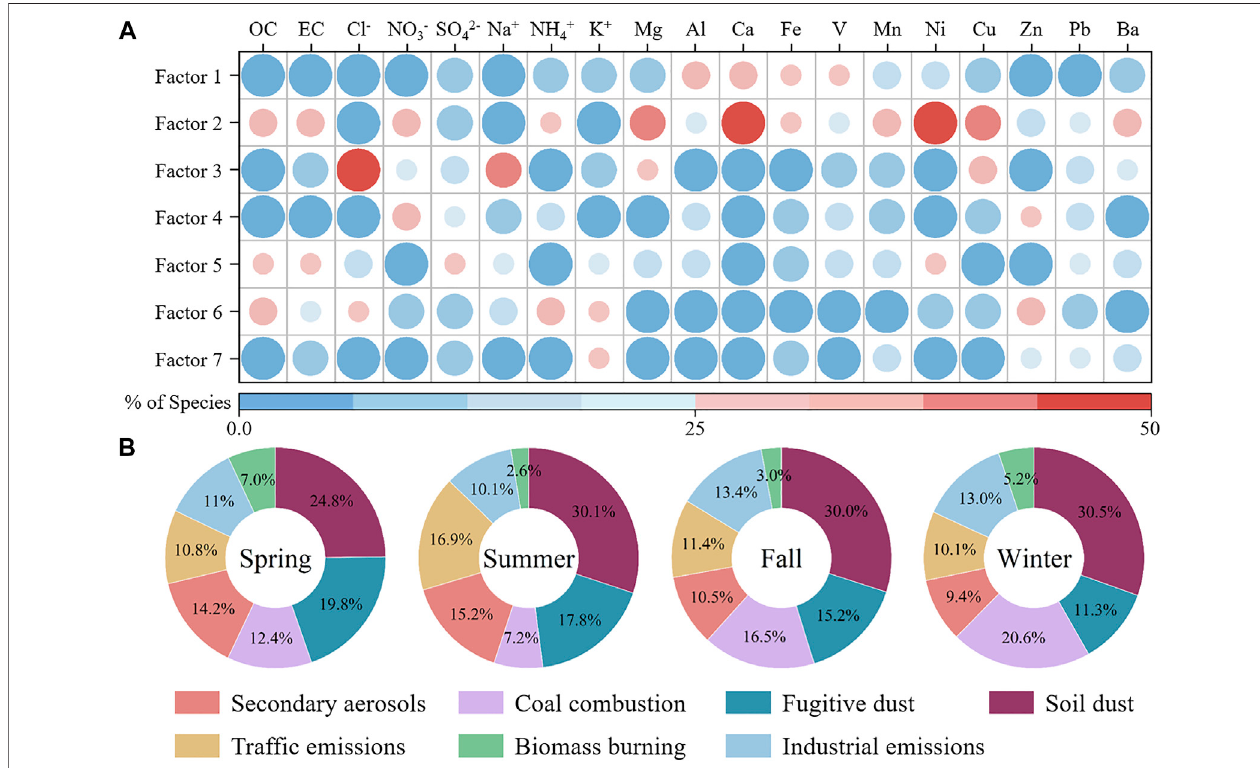
FIGURE5 | The PMF model wasused toanalyze thesource factor pro fi les (A) and their relative contributions to PM 10 in four seasons (B) in Jiuquan city. The color gradient represents the contribution of a certain chemical component to the source.